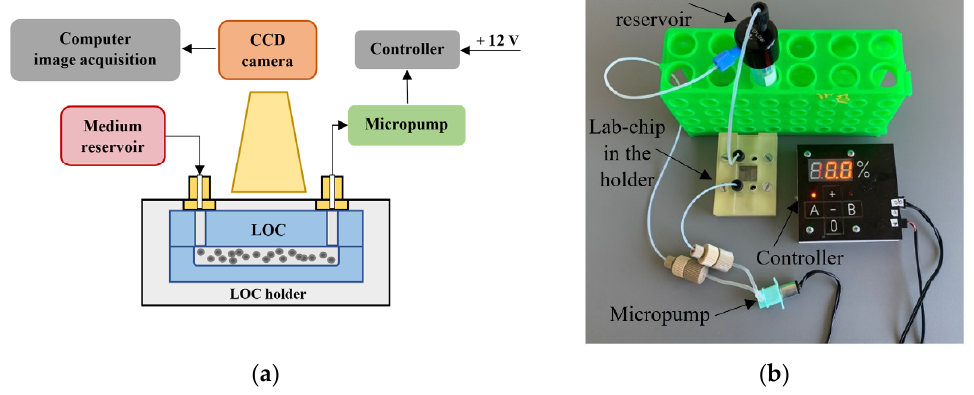
Figure 2. LOC platform: ( a ) detailed scheme, ( b ) platform under operation. A 15 mL falcon tube for the culturing buffer with the microfluidic adapter (model: LVF-KPT-S-2, Elveflow, Paris, France) ensuring assembly of the microfluidic fittings (model: LVF-KFI-06, Elveflow, Paris, France) is used here as a medium reservoir. Minia- turized peristaltic micropump (model: RP-Q1.5S-P45Z-DC3V, Takasago Fluidic Systems, Nagoya, Japan) is operated by the micropump controller equipped with ATtiny 48 micro- processor (Atmel, Chandler, AZ, USA) to maintain the flow of culturing media in LOC in the range of 250 µL/min. Embedded software of the micropump controller (written in AVR Assembler) manages to command up to 2 micropumps independently. The medium flow is switched herein every 24 h for 20 s. Current flow settings are presented in the LED display of the micropump controller. The power consumption of the lab-on-chip system is circa 2 W (1 W is needed for the micropump operation, and an additional 1 W is used for the micropump controller). The system is powered by 12 V power supply. Depending on the experiment type and cancer cell line, different culturing media were used, whose specification is described in the Section 2.3. The LOC for each of the tests is placed in the 3D printed holder to provide overall protection of the structure and precise placement of the microfluidic connectors (Flangeless Fittings, Idex Health and Sci- ence, Oak Harbor, WA, USA). The observation of the cultures is carried out every 12 h with the use of a microscope optical detection system (Olympus CKX41, CCD camera SC30, Tokyo, Japan). The images of the cell colonies are acquired and analyzed utilizing the dedicated computer software (Stream Start 1.0). Depending on the experimentation cycle, the microfluidic platform is placed to the incubator (NuAire NU-5510 E, Plymouth, NA, USA) or heater (Biometra OV3, Selftec GmbH, Borken, Germany) with temperature set to 37 °C. 2.2. The Construction and Technology of LOC The microfluidic chips devoted to biomedical experiments have to meet specific de- mands of the cells, e.g., ensure fresh culturing media dosage and oxygen diffusion to sup- port appropriate colony growth on-chip [34,35]. For this reason, culturing LOCs are typi- cally equipped with microchambers, microchannels and via holes. Capacity of the micro- chambers and microchannels is also important since it must provide sufficient space for the colony development and do not confine and impede the potential growth. Our major goal herein was to provide the most universal LOC solution, able to ensure physiological growth of as many cancer-cell lines as possible. The design of LOC is shown in Figure 3.